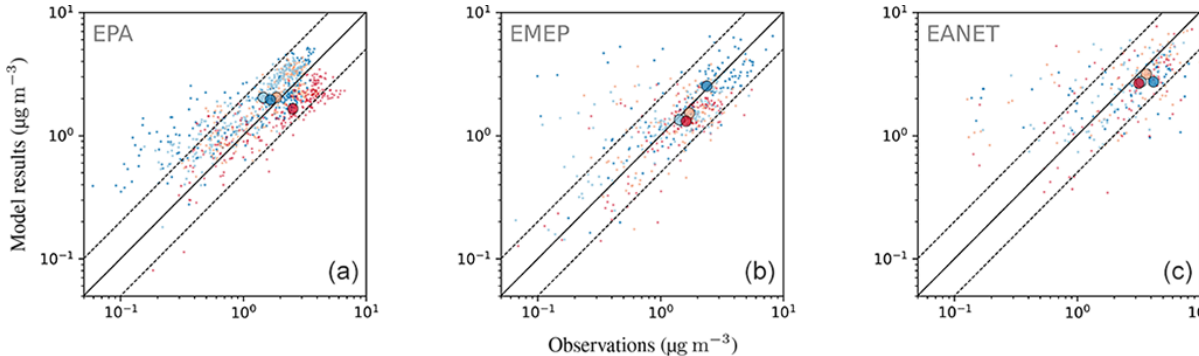
Figure 20. Scatterplots of observed and simulated monthly average SO 2 − concentrations for the year 2010 and three observational networks: 4 EPA, EMEP and EANET (a–c) . The colouring of the points represents a categorization into seasons (dark blue: DJF; orange: MAM; red: JJA; light blue: SON); the seasonal averages of monthly concentrations are depicted as large circles. Dashed lines denote the interval of a factor of 2 of the observations. The simulated concentrations were obtained by sampling the modelled data at the respective station locations using bilinear interpolation over neighbouring grid points.